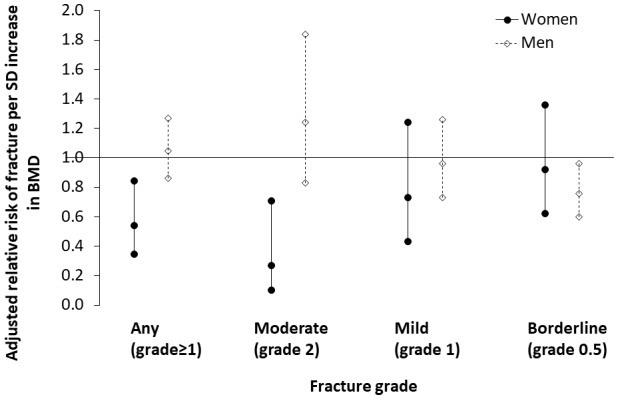
Association between thoracic vertebral BMD and thoracic vertebral (T6–T12) fracture risk (95% CI) for Tsimane.Log-binomial generalized linear models are used to estimate relative risk after adjustment for age, height and fat mass. Mean IBI is also included as a covariate for women. Parameter estimates are shown in Appendix 1—tables 13–14 (women), and Appendix 1—tables 16–17 (men). Severe fractures (grade 3) are omitted due to their relative scarcity.